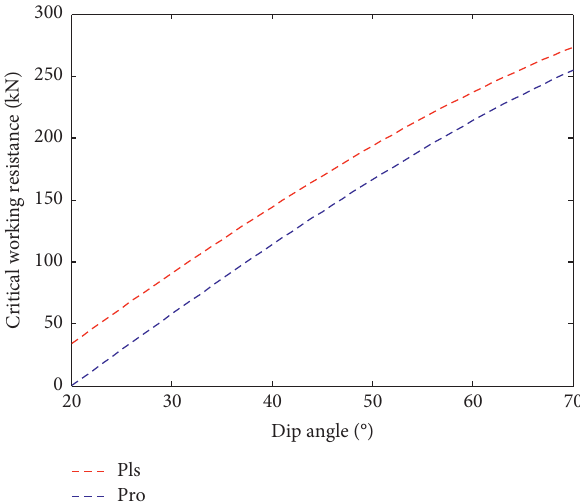
Figure 11: Relationship between the critical work resistance and dip angle of the coal